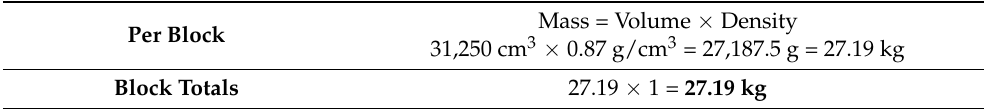
Table 3. Perma-Gel waste generation from survivability assessment scenario.